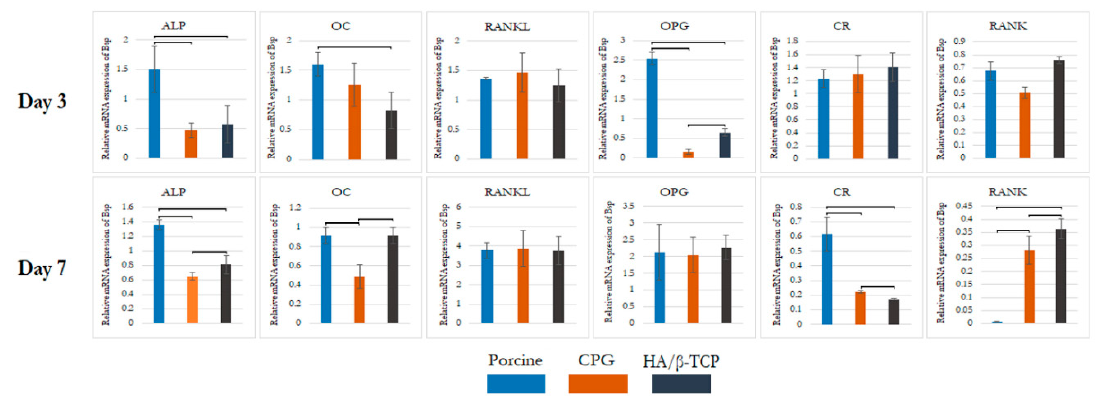
Figure 5. MG-63 gene expression on days three and seven. CPG, porcine graft, and HA/ β -TCP in MG-63 osteoblast-like cells induced greater osteoblast gene expression than the control. Statistically significant differences were observed between the groups each day and between days compared to the control, which was established as day zero. Statistically significant differences were set at p < 0.05 and are indicated by asterisks (*).